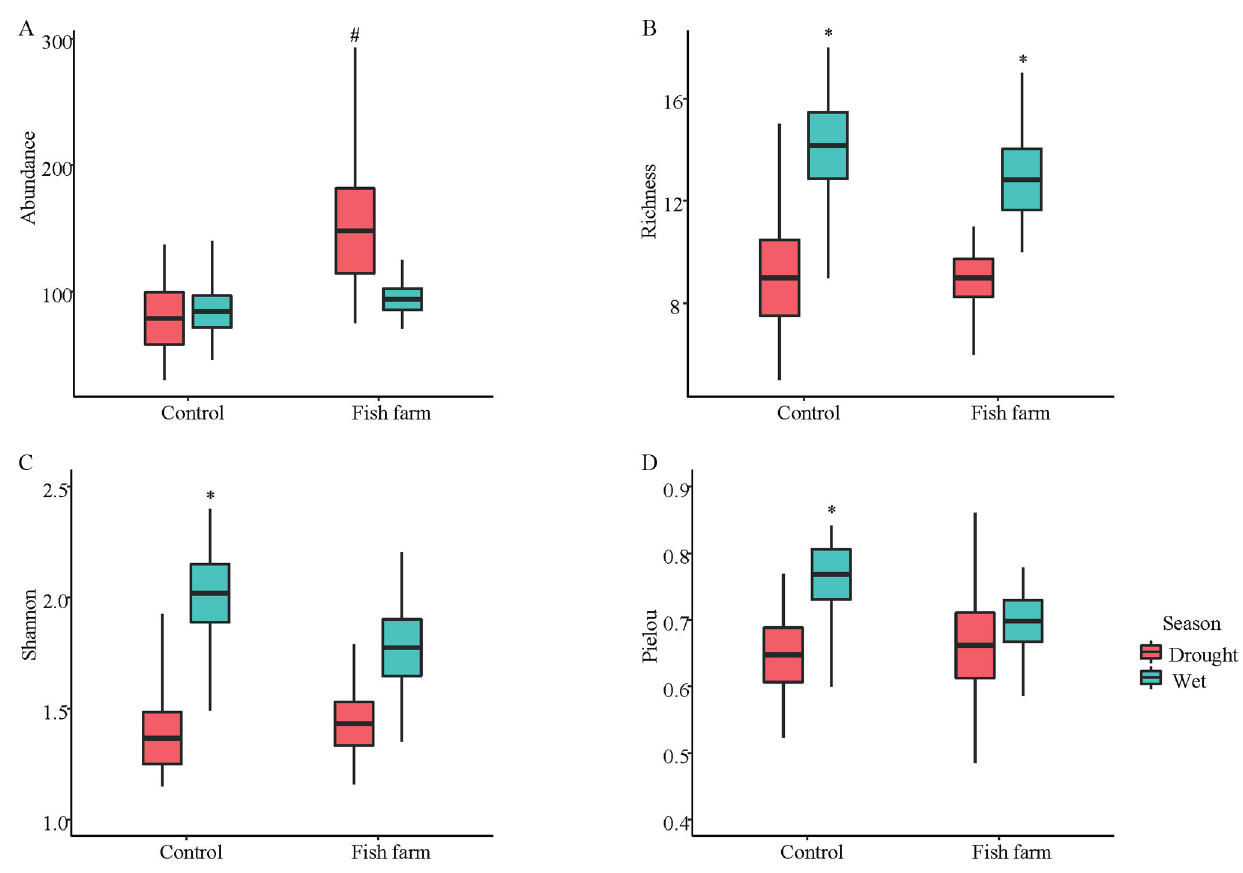
FIGURE 3 | Box plots (minimum and maximum value = vertical line ends, standard error = box, and mean = horizontal line) of the ichthyofauna attributes in the control area and fish farm area, in the drought and wet seasons at the Ilha Solteira reservoir, Upper Paraná River, SP, Brazil. A. Total abundance; B. Species richness; C. Shannon index; D. Pielou evenness. Asterisks indicates significant upper value between seasons within each area. Hash indicates significant upper value between areas within each season.